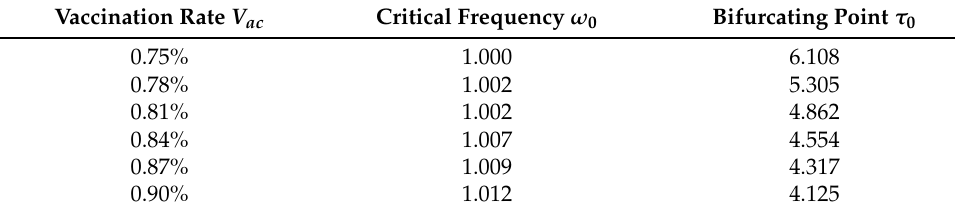
Table 4. Vaccination rate V ac and bifurcating point τ 0 .